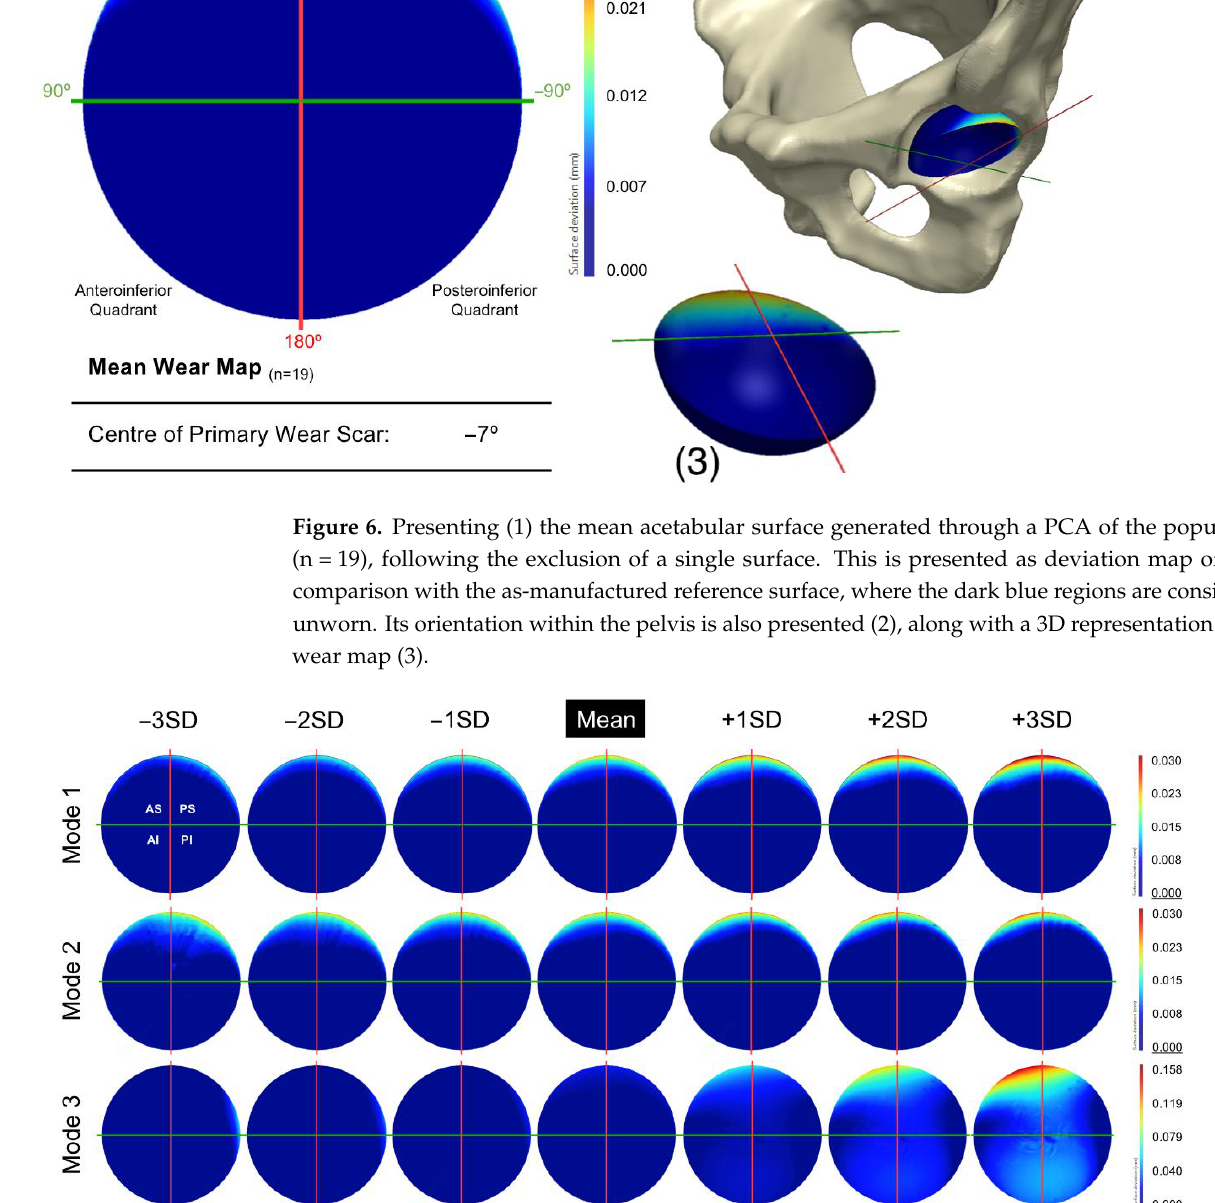
Figure 7. The change in geometry from −3SD to +3SD of the first 3 principal components (modes) calculated from this population of acetabular surfaces, presented as deviation maps of their comparison with the as-manufactured reference surface (mm).